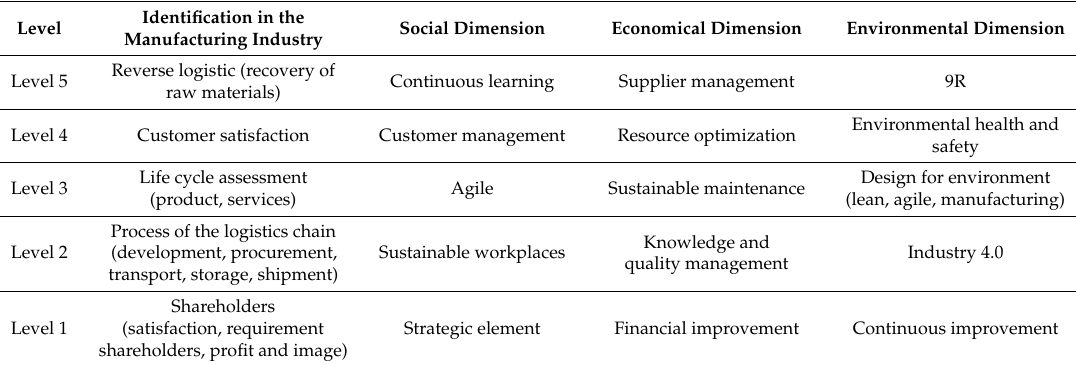
Table 7. Defining the hierarchical framework.